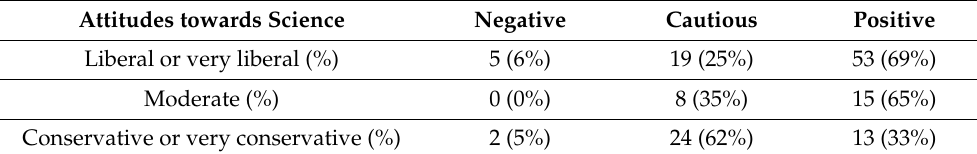
Table 9. The relationship between attitudes towards science and ideology.